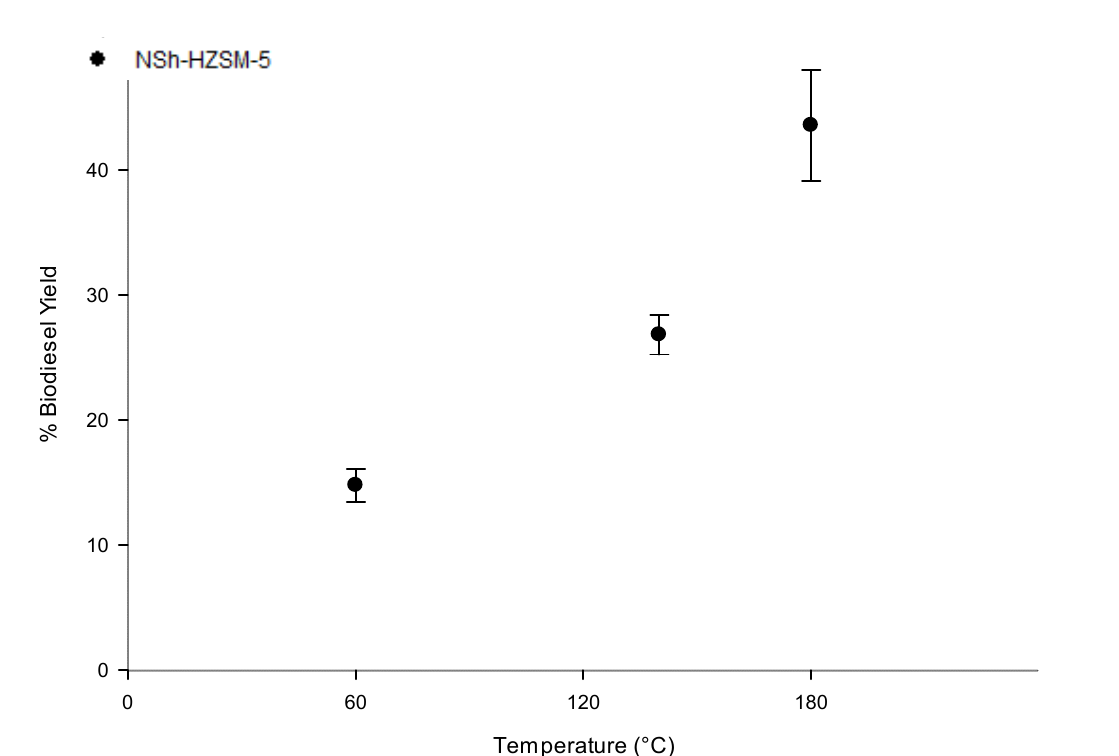
Figure 8. Effect of reaction temperature variation on the transesterification of WFO using NSh ‐ HZSM5 catalyst at 10 wt % catalyst loading, methanol to WFO molar ratio of 12:1, 550 rpm, and 6 h.